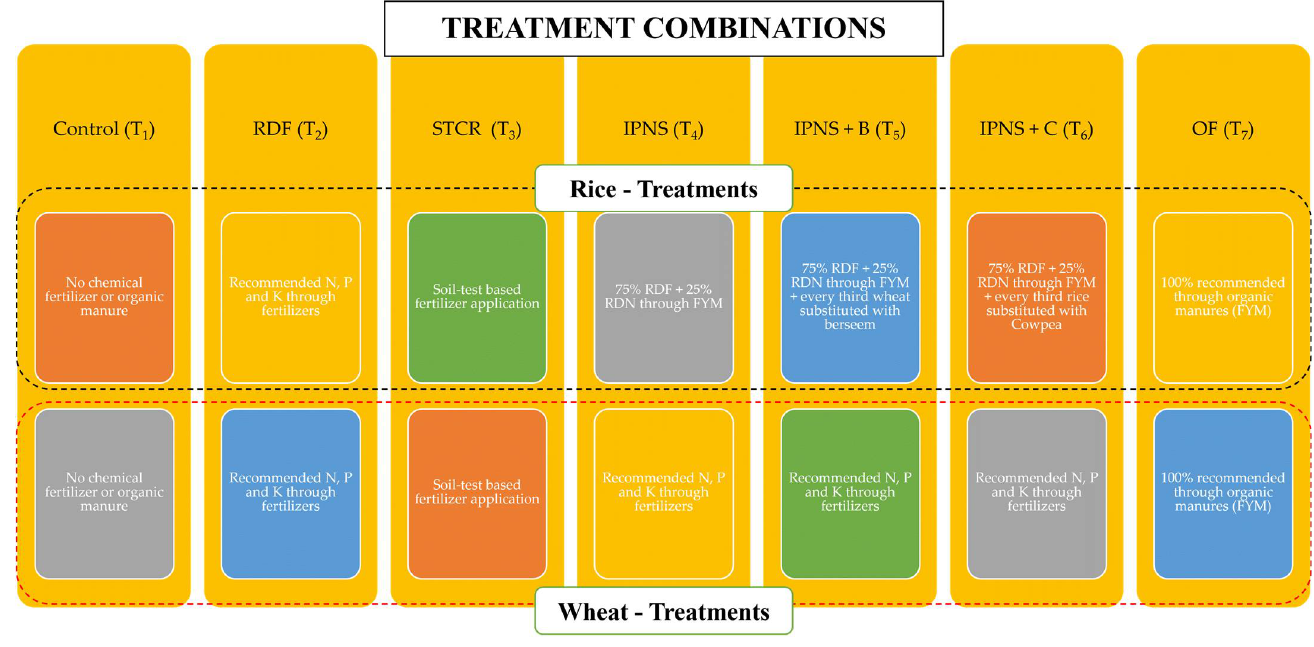
Figure 2. Treatment combinations used during experimental periods.